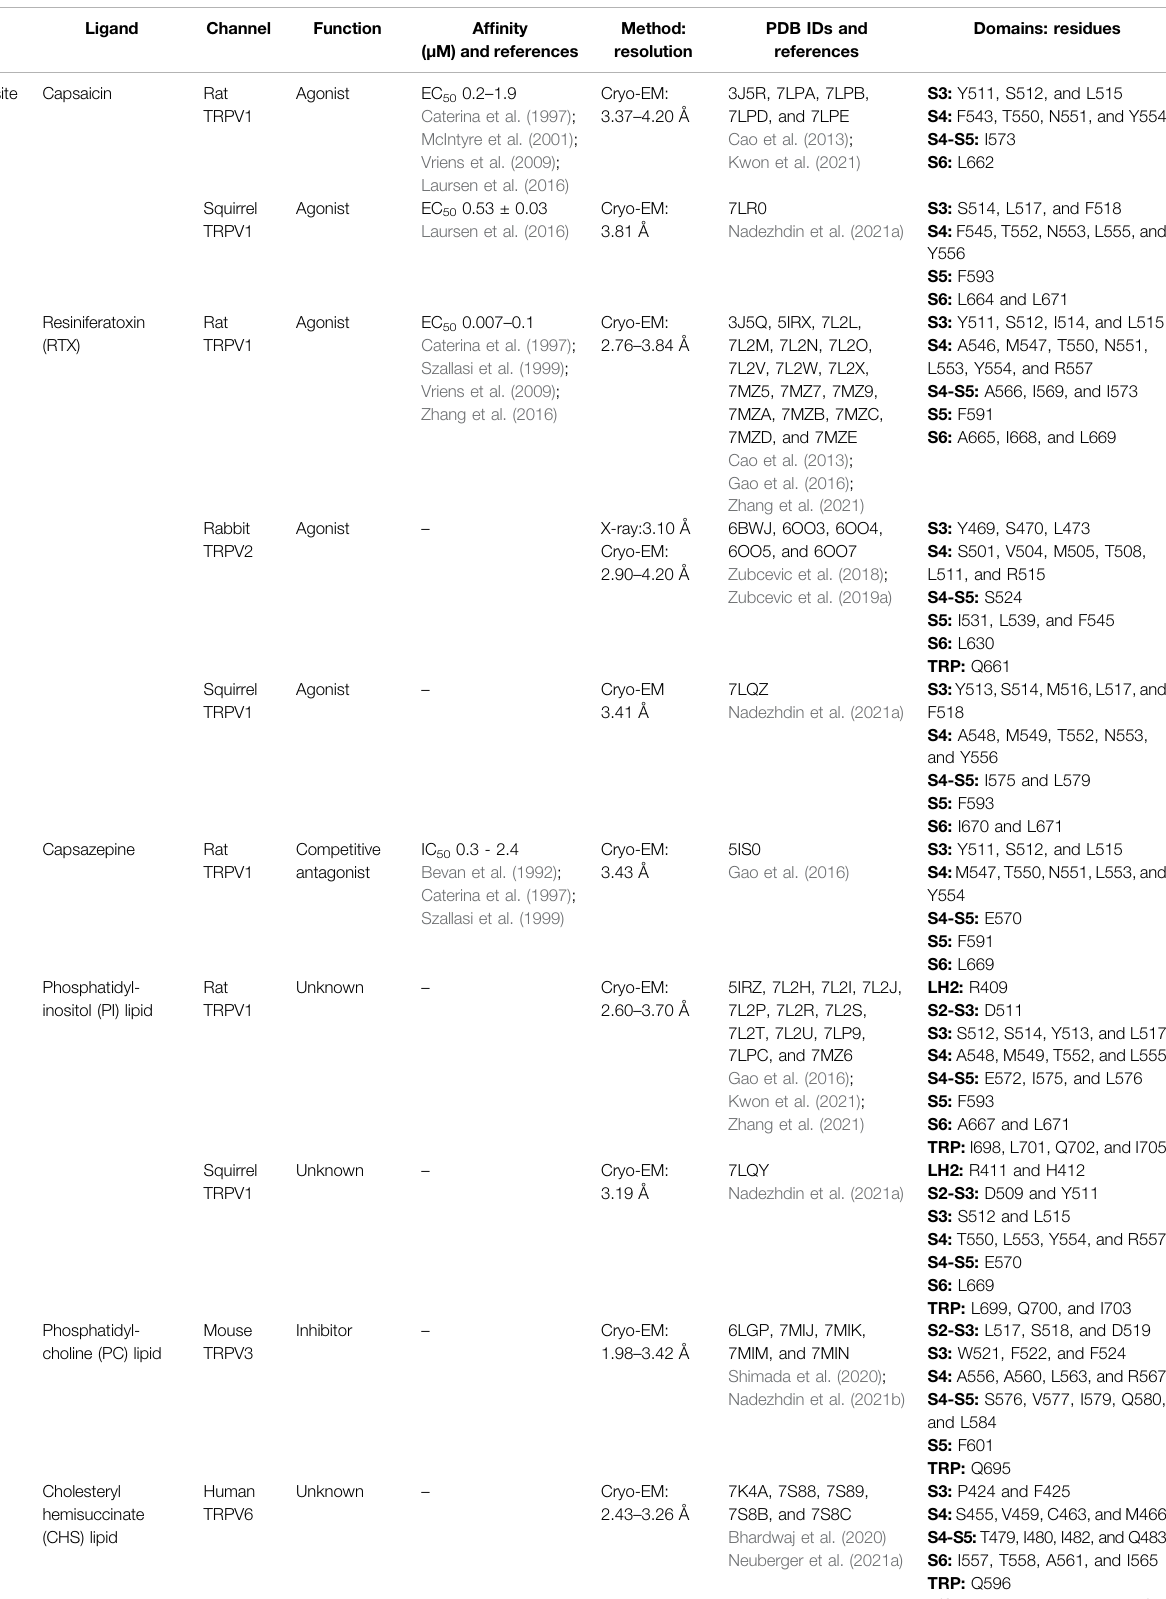
TABLE 1 | Ligand binding sites in TRPV